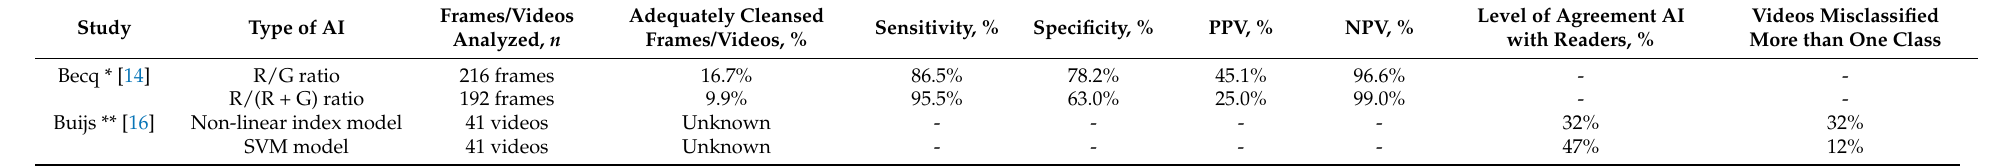
Table 4. Results of the two included studies examining computed assessment of bowel cleansing in CCE.